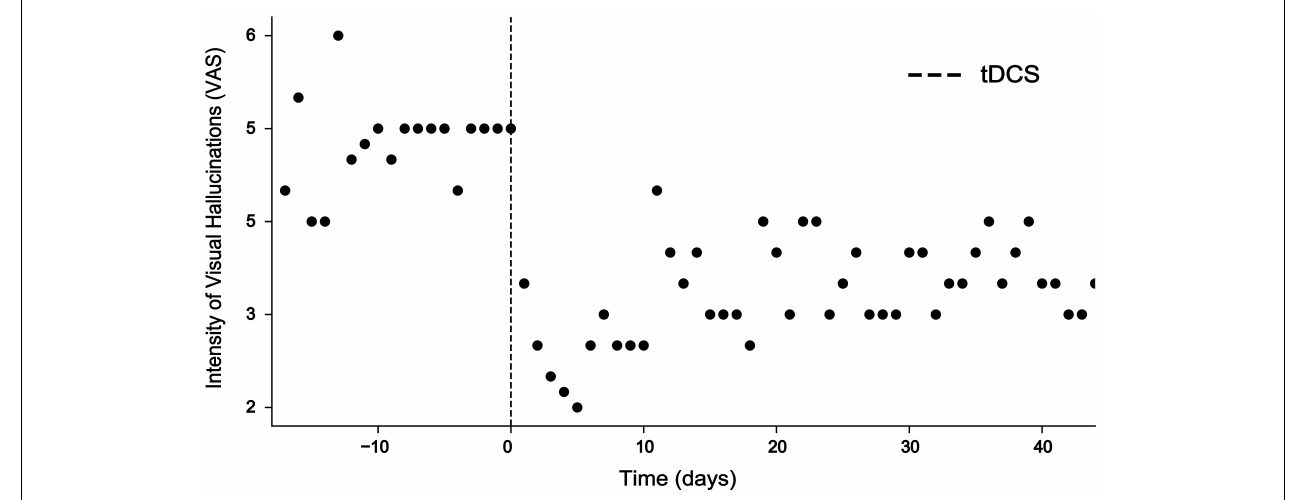
FIGURE 2 | Intensity of visual hallucinations rated on a visual analog scale (VAS) ranging from 1 = minimal to 10 = extreme before and after intervention. While VAS scores ranged at around 5 before intervention, tDCS resulted in a highly significant decrease of VAS scores for 10 days (Mann–Whitney U test, p < 0.001***) and remained reduced for more than 40